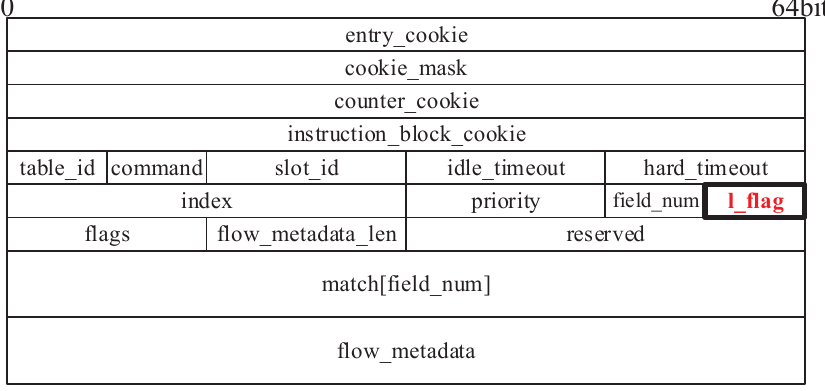
Figure 2. FLOW_MOD message of the extended POF southbound interface